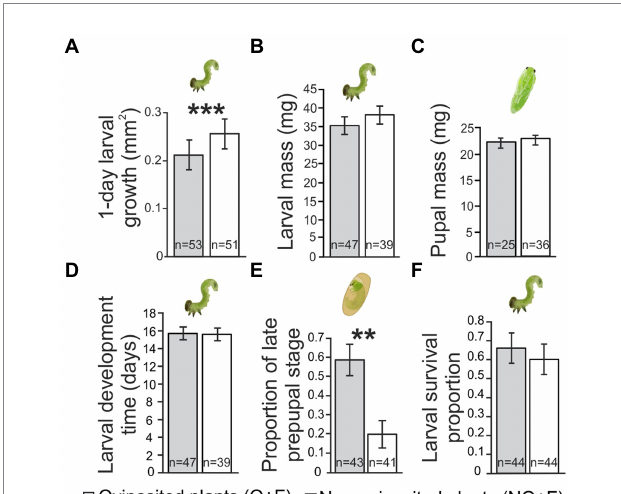
FIGURE 3 Performance of N. oligospilus on S. babylonica that had been subjected to prior oviposition (gray bars) or no oviposition (white bars; A–F ). Means ± estimated standard errors are shown for all values. Statistical analysis for mean values was performed by LMMs, and proportions by Wald χ 2 test. Asterisks (**/***) indicate significant differences between larvae on O + F and NO + F plants at p < 0.01/0.001. Total number of larvae per treatment is shown inside each bar. Biological replicates (plants) per treatment: N = 5.